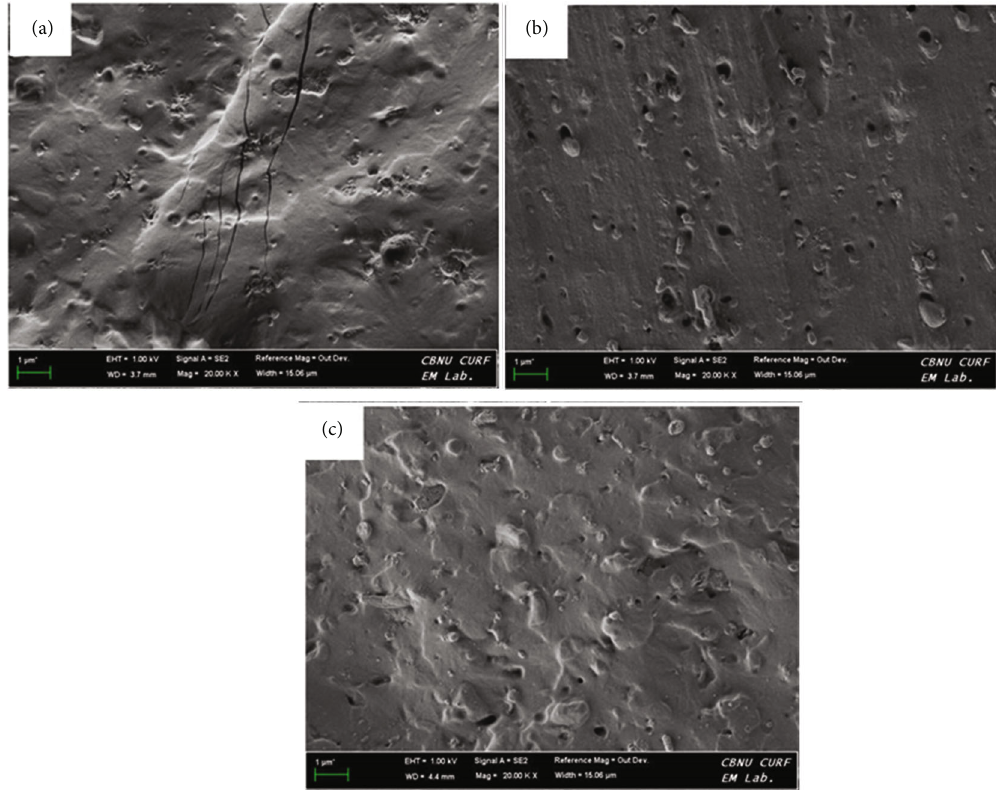
Figure 2: Morphological properties of compounds by SEM analysis: (a) NBR. (b) NBR – rGO-1. (c) NBR – GO-1.